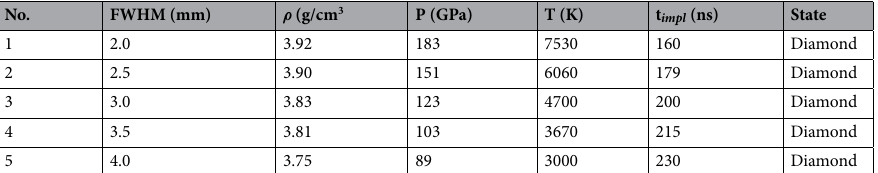
Table 4. Achieved physical conditions in compressed carbon using bunch intensity = 3 × 10 11 uranium ions, bunch length = 200 ns, particle energy = 2 GeV/u, initial sample radius, R si = 200 μm, sample mass = 2.8 mg/